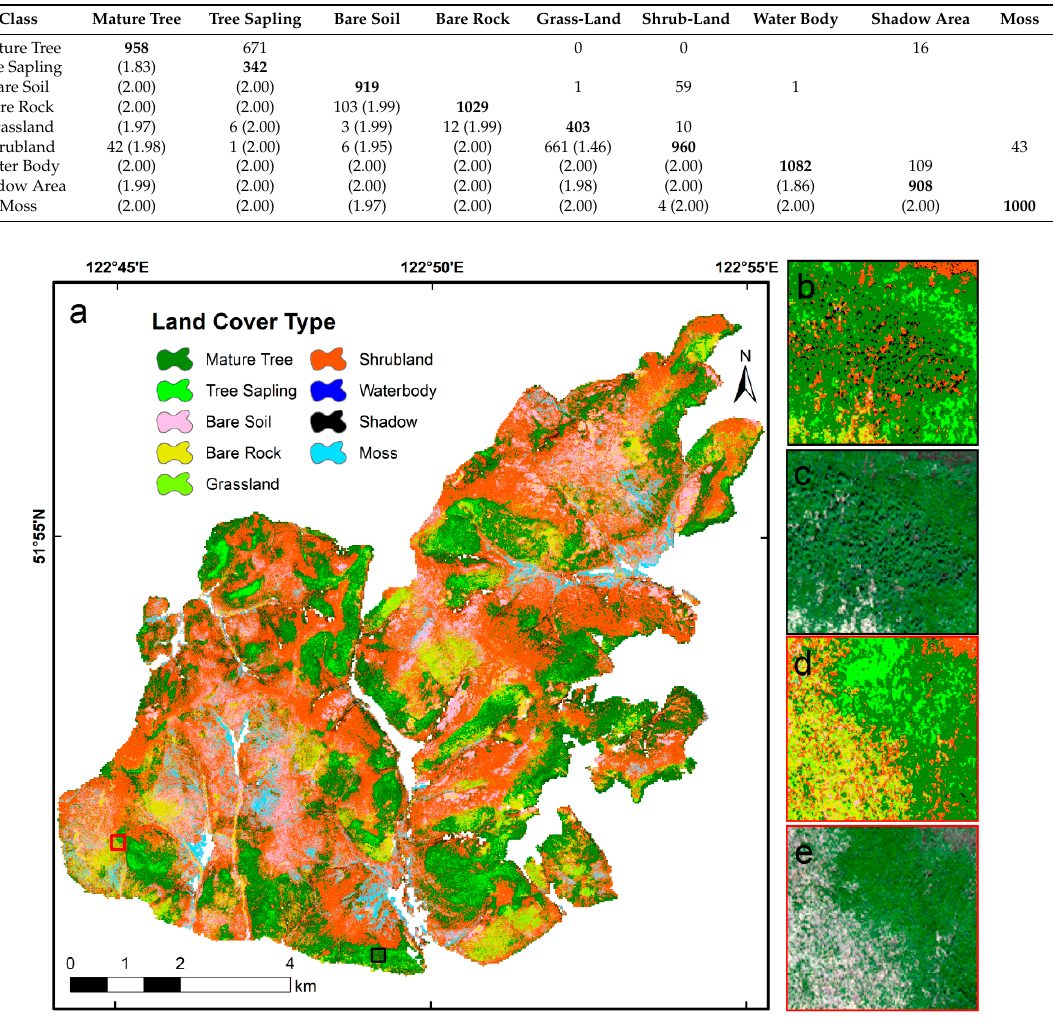
Figure 3. Land cover mapping of the burned area ( a ) based on WorldView-2 imagery. Small windows ( b – e ) show zoomed views of land cover maps ( b , d ) compared to the RGB imageries ( c , e ) for two sites (black box for b , c , red box from d , e ) respectively.